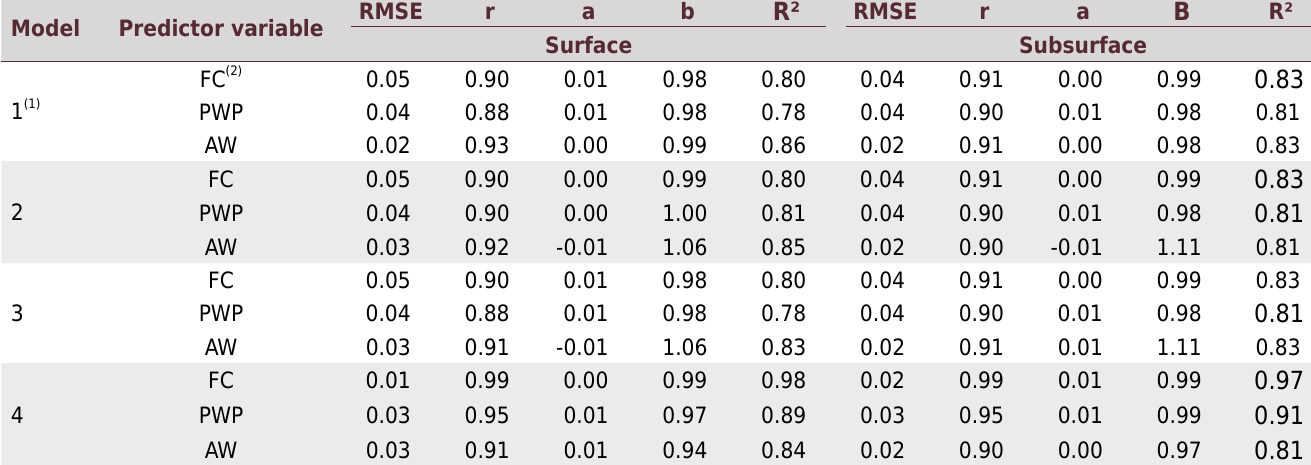
Table 5. Root mean square error (RMSE), correlation coefficient (r), intercept (a), angular coefficient (b), and coefficient of determination (R²) for relationship between measured moisture and estimated moisture by regression trees (RT) with the surface and subsurface horizons database Model Predictor